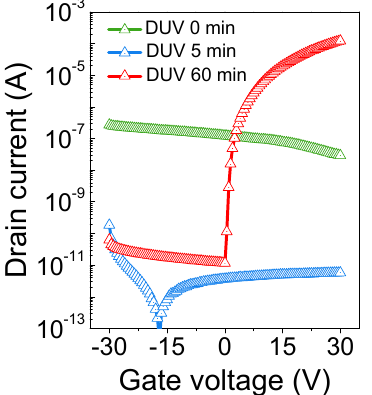
Figure 2. Variations in the transfer characteristics of indium ‐ gallium ‐ zinc oxide (IGZO) thin ‐ film transistors (TFTs) with increasing DUV irradiation period. The TFTs were fabricated by using as ‐ spun, 5 ‐ min DUV ‐ annealed, and 60 ‐ min DUV ‐ annealed IGZO channels ( V D = 30 V, W / L = 1000/70 μ m).